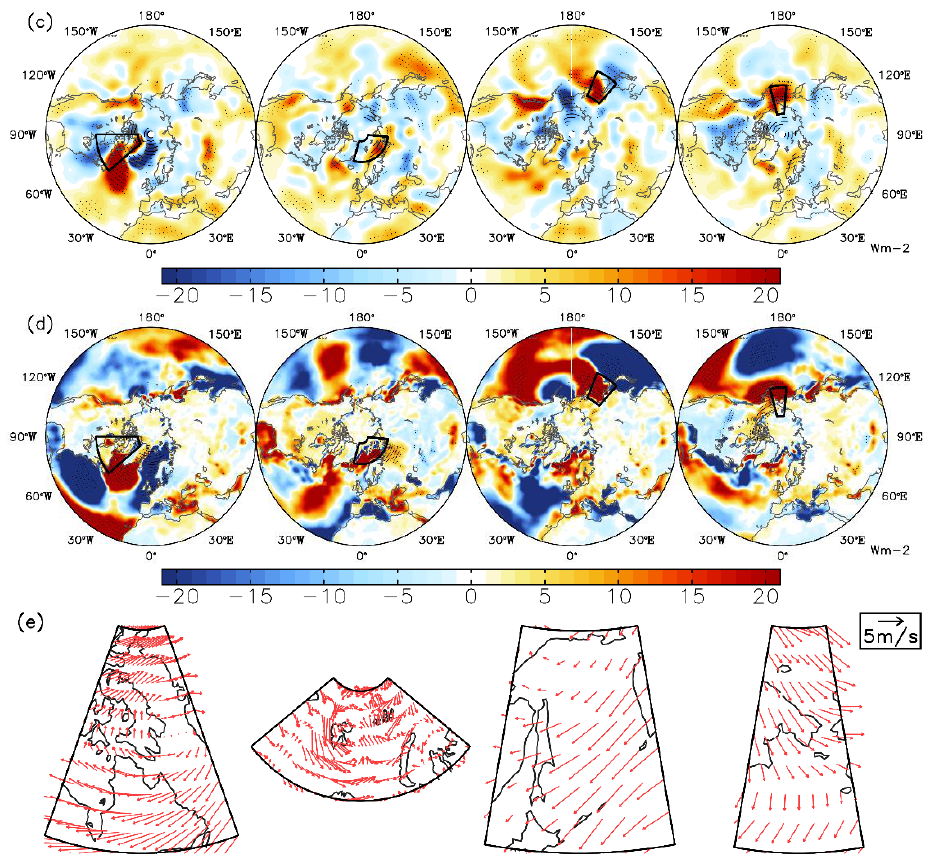
Figure 7. Composites of the regional blocking events from lag −2 to lag 2 days for ( a ) surface downward IR anomaly, ( b ) precipitable water anomaly, ( c ) 850-hPa horizontal temperature advection anomaly, ( d ) sum of surface sensible and latent heat flux anomaly and ( e ) 10 m wind vector. The dotted areas represent values that are above the 95% confidence level based on a two-sided Student’s t test. Black boxes represent four key SIC regions. In (e), only regions within black boxes are plotted. The units are W m −2 in ( a , c – f ) and kg m −2 in ( b ).